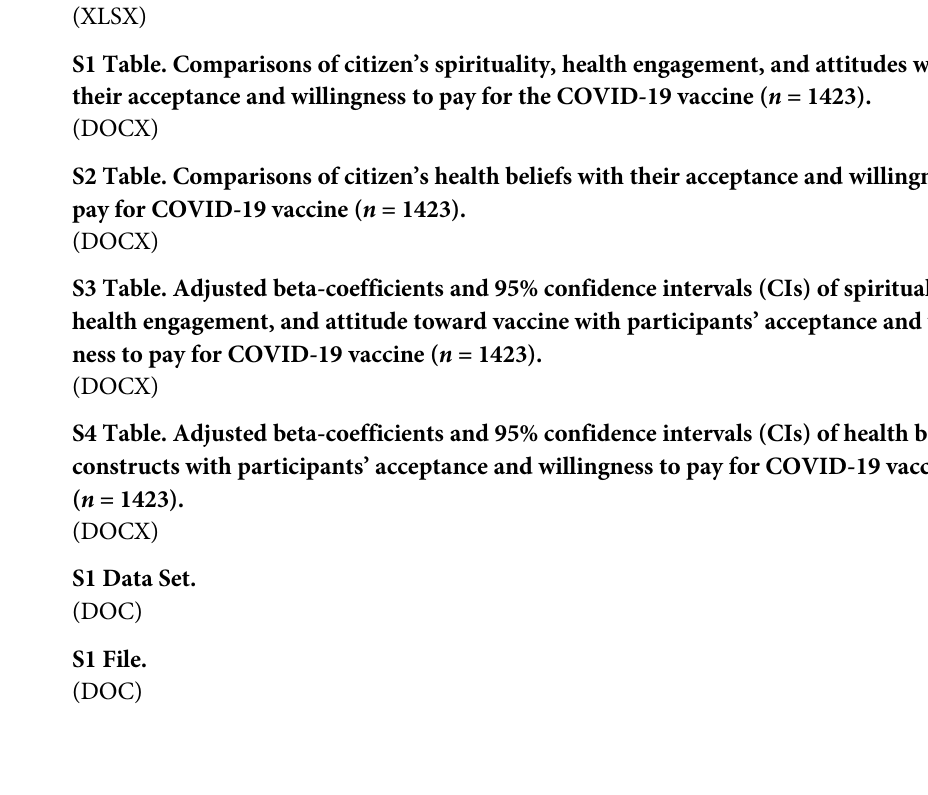
S1 Table. Comparisons of citizen’s spirituality, health engagement, and attitudes with their acceptance and willingness to pay for the COVID-19 vaccine ( n = 1423). S2 Table. Comparisons of citizen’s health beliefs with their acceptance and willingness to pay for COVID-19 vaccine ( n = 1423). S3 Table. Adjusted beta-coefficients and 95% confidence intervals (CIs) of spirituality, health engagement, and attitude toward vaccine with participants’ acceptance and willing- ness to pay for COVID-19 vaccine ( n = 1423). S4 Table. Adjusted beta-coefficients and 95% confidence intervals (CIs) of health beliefs constructs with participants’ acceptance and willingness to pay for COVID-19